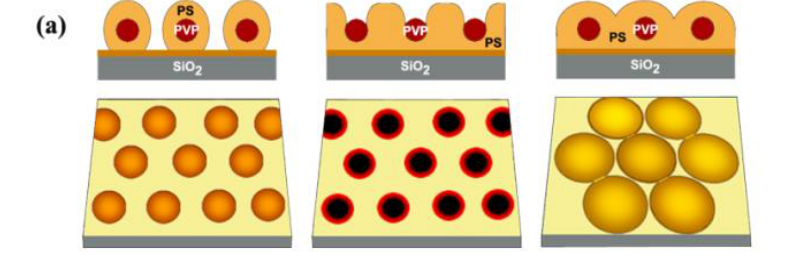
Figure 5. Two-dimensional diblock copolymer templates of PS- b -PVP and protein assembly behavior observed on them; ( a ) various nanoscale templates resulting from chemical modification of nanodomains in micellar-forming diblock copolymers, ( b and c ) immunoglobulin G molecules on (b) open and (c) reverted PS- b -PVP templates, and ( d ) mushroom tyrosinase molecules assembled on a reverted PS- b -PVP template. The atomic force microscopy (AFM) scan size in panels (b) through (d) corresponds to (b): (2) 300 × 300 nm, (3) 180 × 180 nm, and (c and d): (2) 300 × 300 nm, (3) 180 × 180 nm. Adapted with permission from